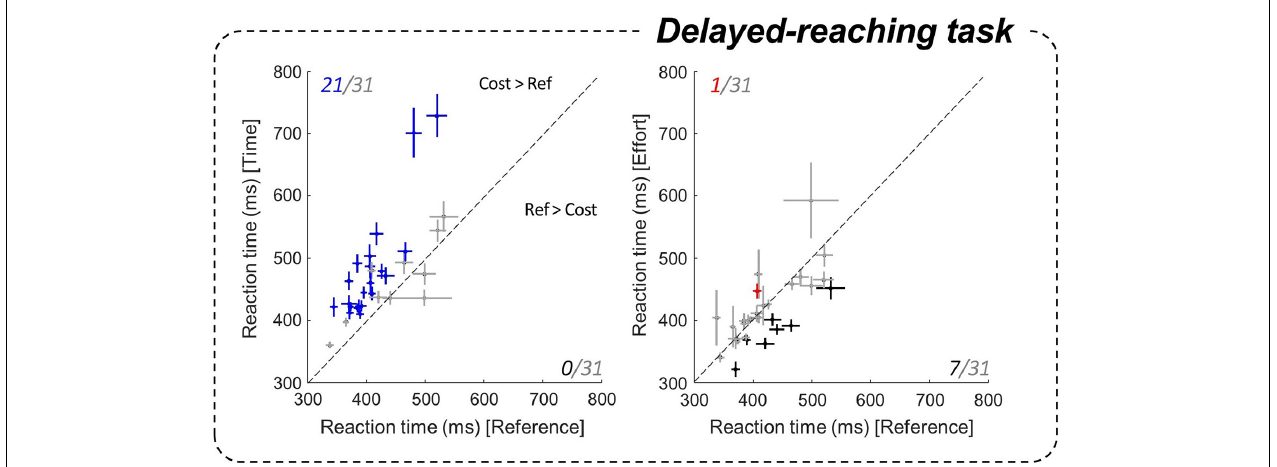
FIGURE 3 | Effect of motor conditions on motor initiation duration. Comparison of subjects’ reaction times (RTs) in the delayed-reach task between the costly conditions (ordinate, left panel: Time / right: Effort) and the Reference condition (abscissa). Pluses indicate the mean and standard error (SE) for each subject. Left panel: blue pluses indicate data that are significantly larger in the Time condition compared to the Reference condition. Right panel: red (black) pluses indicate RTs that are significantly larger (smaller) in the Effort condition compared to the Reference condition.